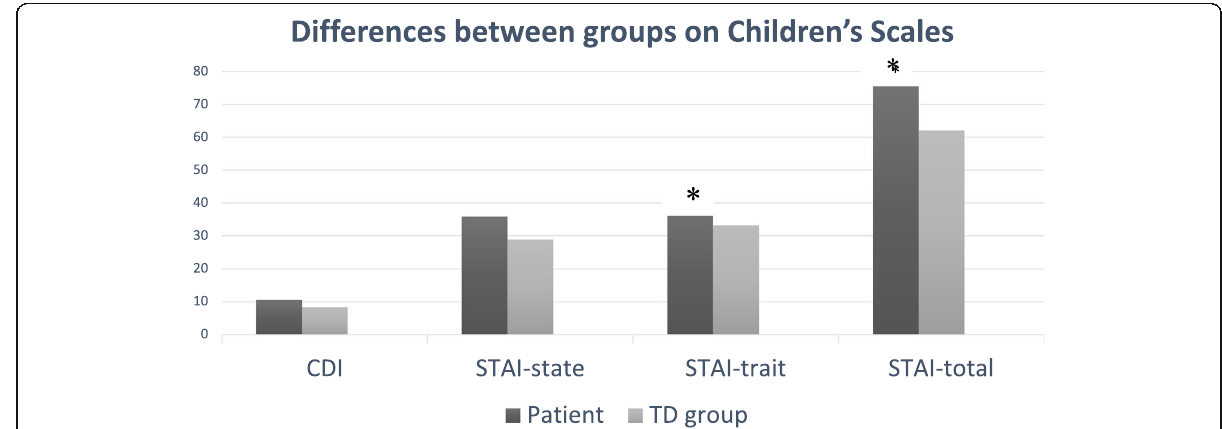
Fig. 1 Differences between groups on children ’ s